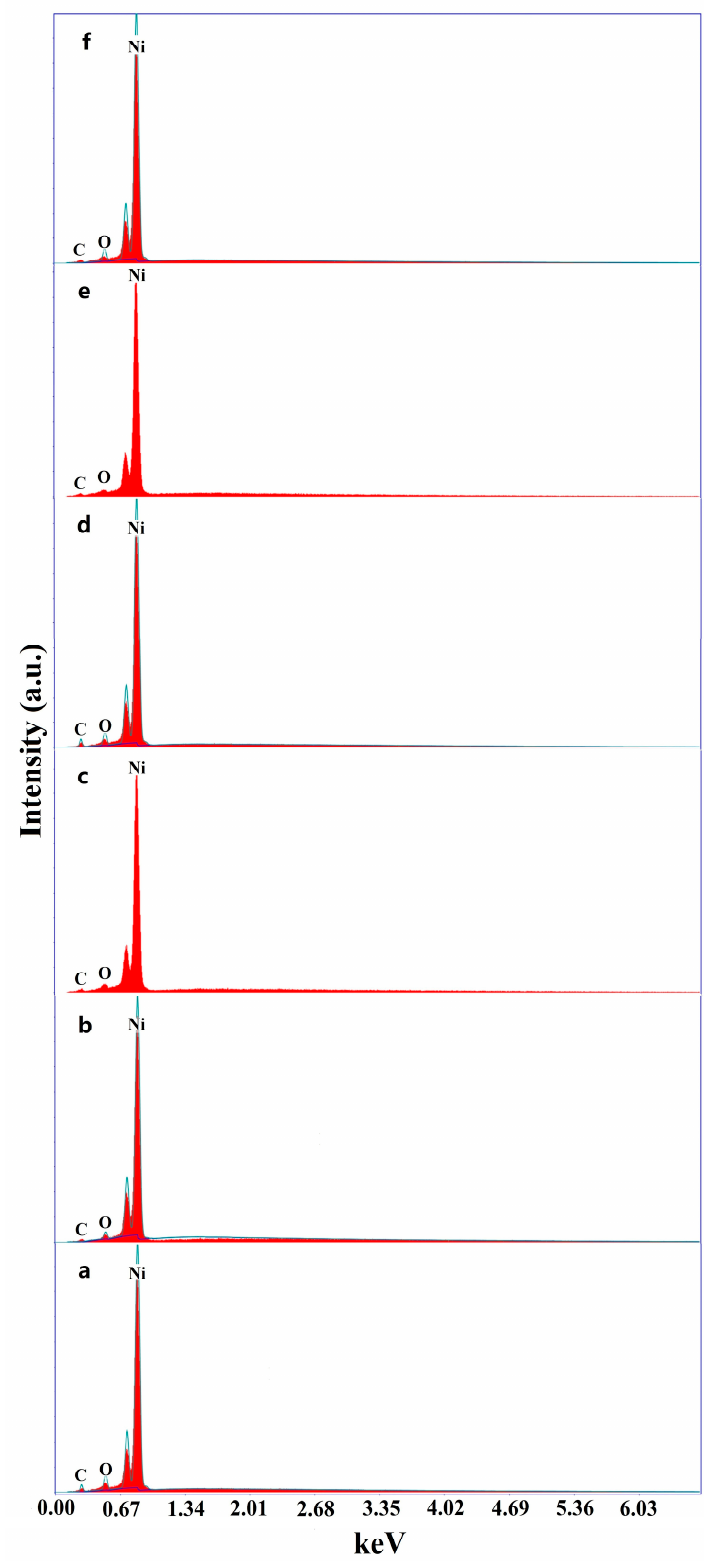
Figure 2. EDS spectra of the Ni surfaces: ( a ) untreated; ( b ) etched by HCl; ( c ) etched by H 2 SO 4 ; ( d ) etched by H 3 PO 4 ; ( e ) etched by HNO 3 ; and ( f ) etched by HF.